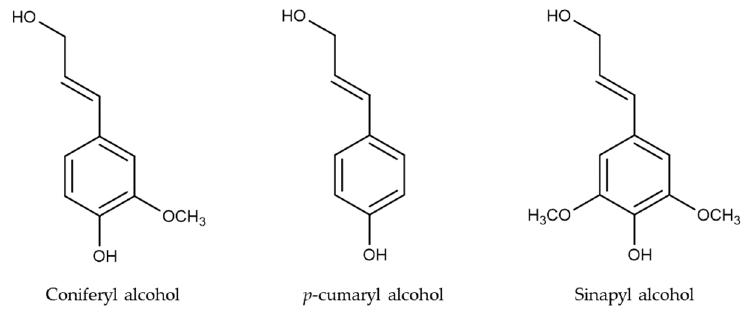
Figure 7. The main precursors of lignin.